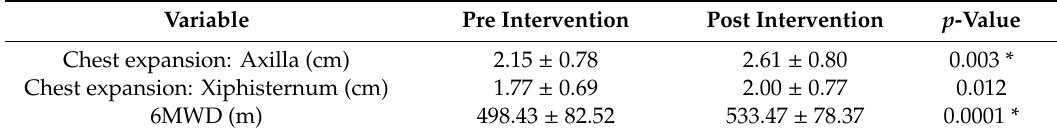
Table 3. Comparison of pre and post intervention chest expansion and 6MWD in the experimental group: Mean ± SD.